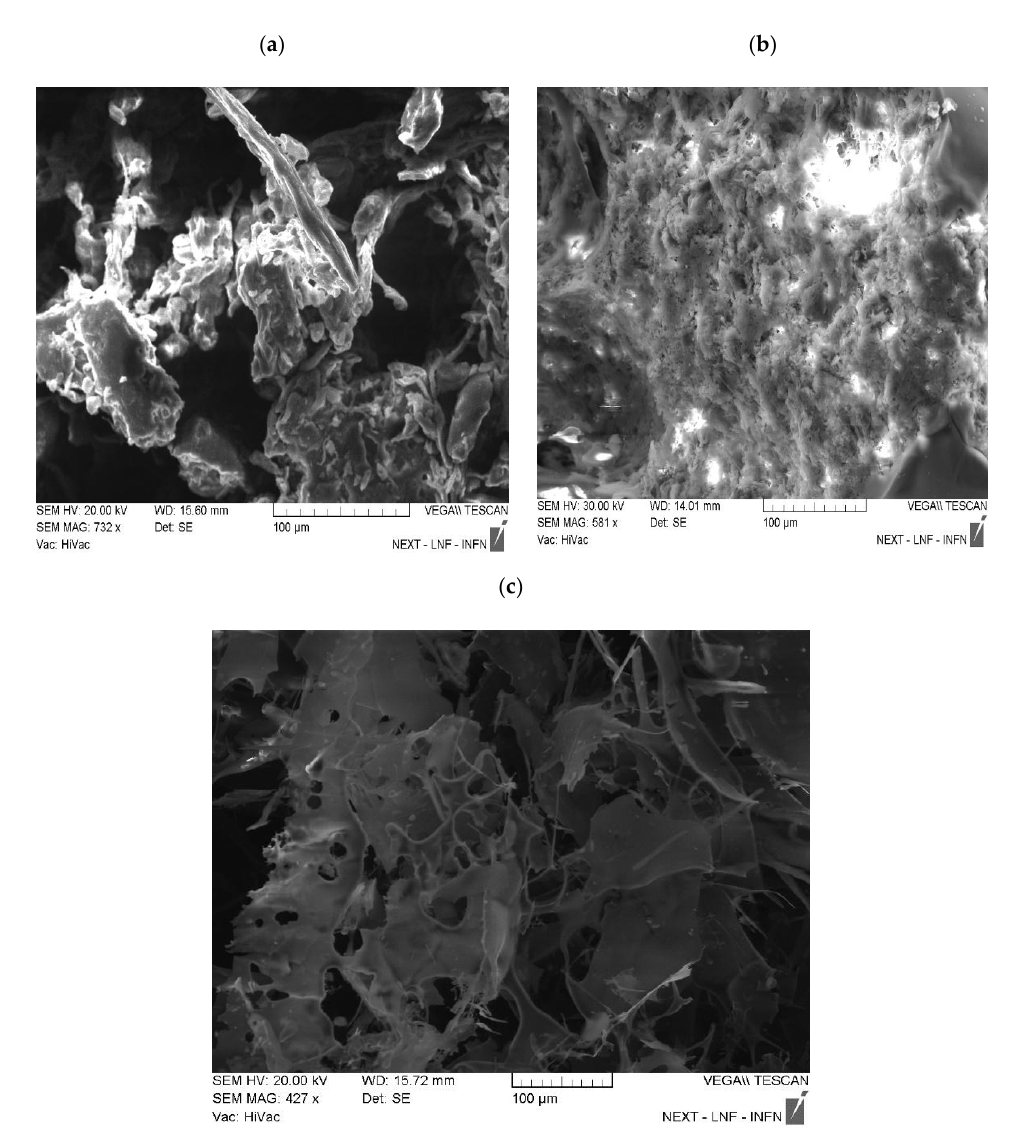
Figure 3. SEM images of ( a ) NaAlg; ( b ) AlgOX; and ( c ) AlgOX-DA.